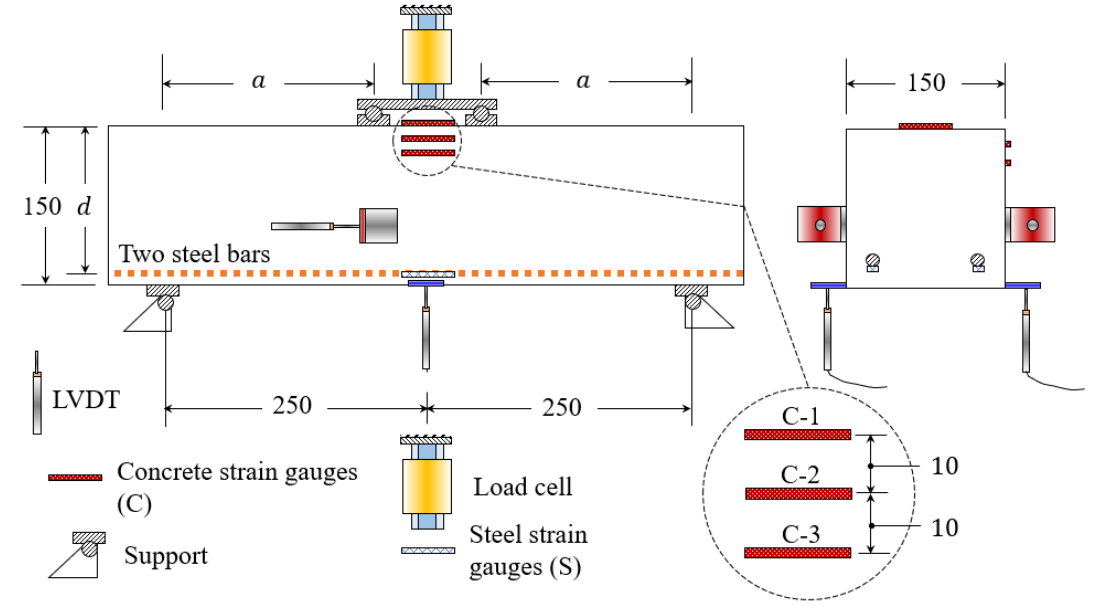
Figure 6. The four-point loading test (dimensions are in mm).